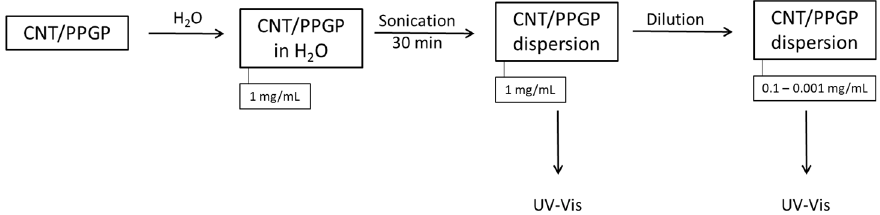
Figure 6. Block diagram summarizing the preparation procedure and characterization protocol adopted for UV-Vis analysis on CNT/PPGP adducts dispersions at several concentrations.